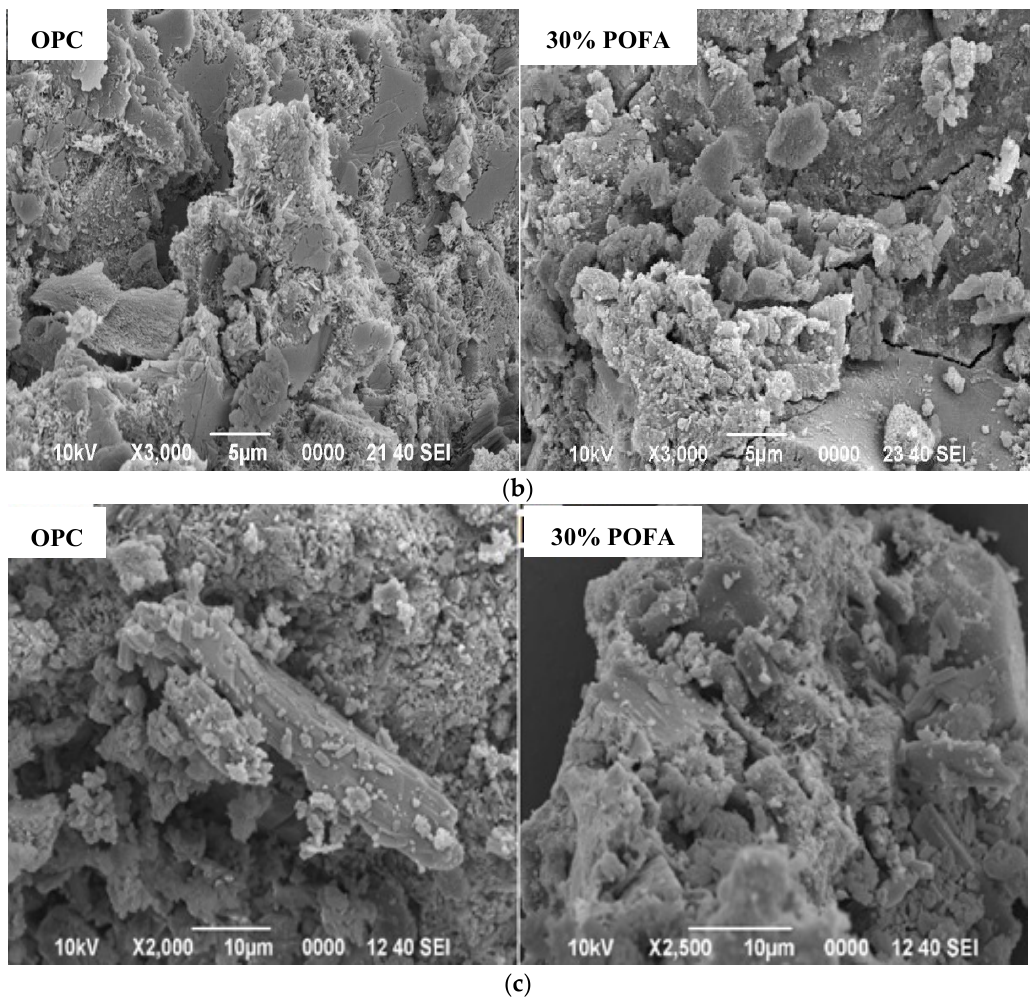
Figure 16. SEM images of plain OPC and POFA matrices at 12 months of exposure in ( a ) water, ( b ) MgSO 4 , ( c ) and H 2 SO 4 solutions.